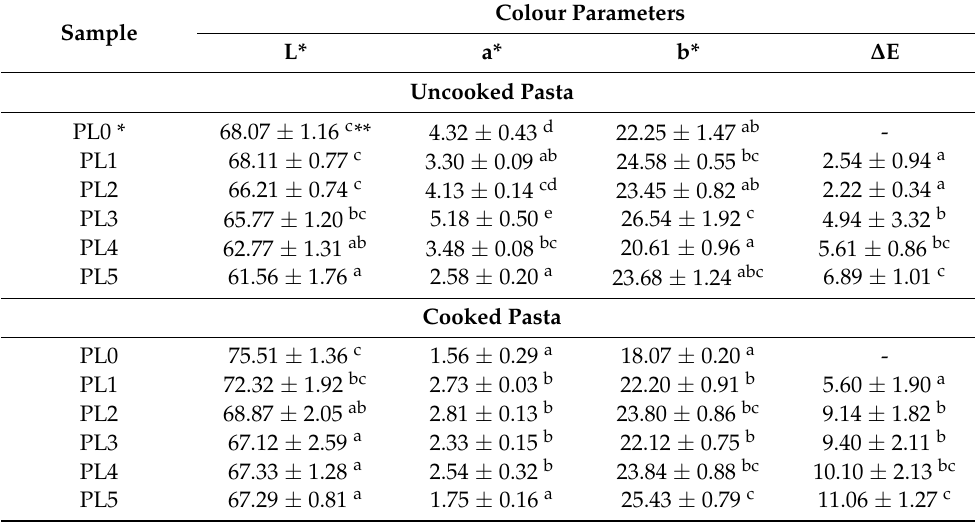
Table 2. The color parameters of uncooked and cooked pasta. Sample